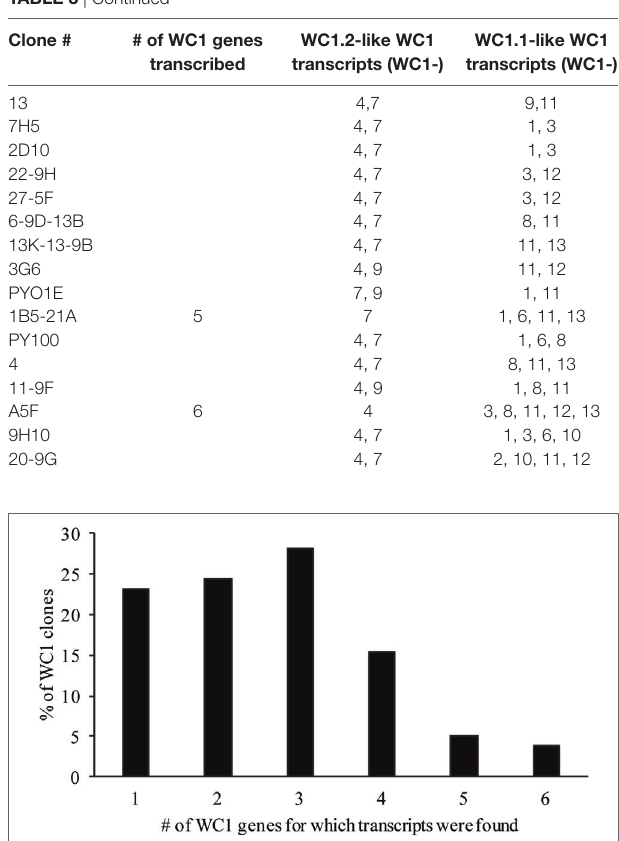
FigUre 3 | Percentage of WC1 transcripts expressed per γδ T cell clone. The percentage of clones with a particular number of different WC1 gene transcripts is shown.